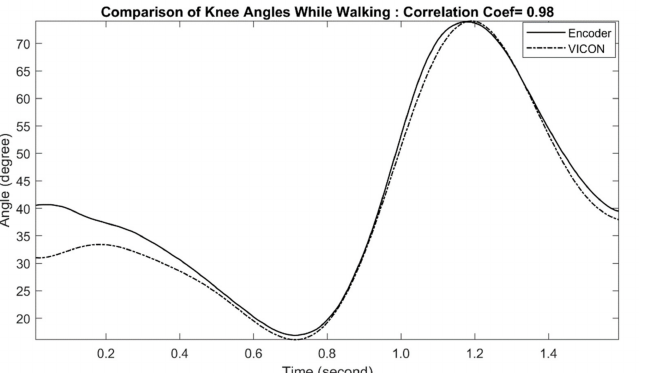
Figure 8. Comparison of Exo-skeleton’s knee angle measurement with reference motion capture during walking. In this data, the correlation coefficient was calculated at